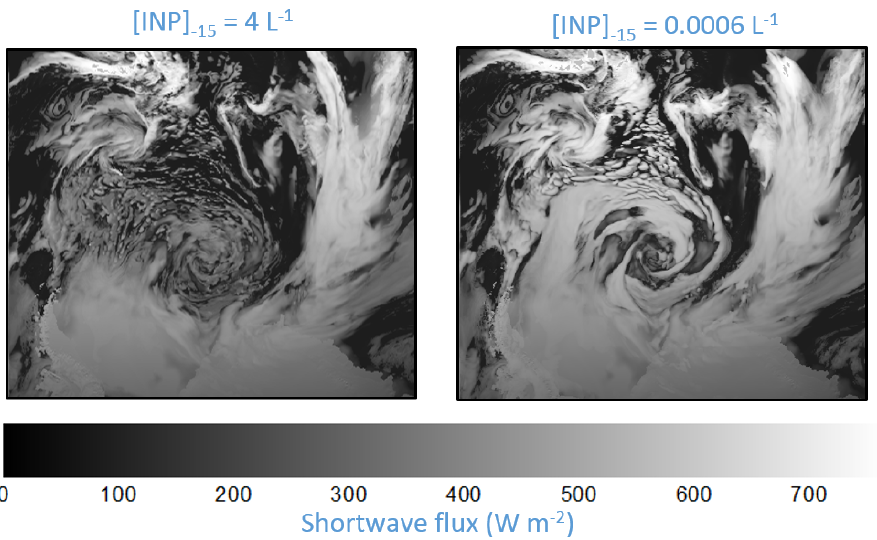
Figure 5. The effect of INP concentration on model clouds in the cold-air sector of a cyclone system over the Southern Ocean with a cloud top temperature of around − 15 ◦ C (adapted from Vergara-Temprado et al., 2018). The case is from 1 March 2015 at 14:00 with 0.07 ◦ grid spacings (roughly 7.7km on a rotated grid). The left map shows a case with a relatively high INP concentration (4L − 1 active at − 15 ◦ C; based on Meyers et al., 1992) and the right map is for a relatively low INP concentration (6 × 10 − 4 L − 1 at − 15 ◦ C, based on Vergara-Temprado et al., 2017). The low INP concentration is a good match to measurements in the Southern Ocean (Schmale et al., 2019; McCluskey et al., 2018a; Welti et al., 2020) and the higher concentration is within the range of measured INP concentrations elsewhere (see Fig. 6). Vergara-Temprado et al. (2018) demonstrate that the lower INP concentration produces clouds which are consistent with satellite measurements of SW flux, whereas the high-INP case suffers a large low bias. In the image, the Antarctic peninsula is visible in the lower left and the Antarctic continent is on the bottom right. The x axis of these plots is approximately 4500km, while the y axis is approximately